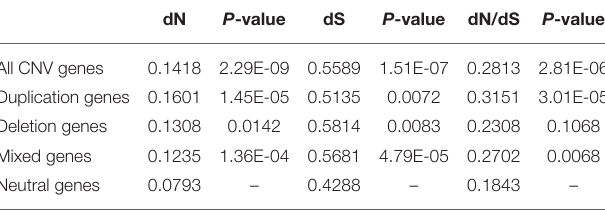
TABLE 4 | dN/dS analysis. TABLE 5 | Number of tissue-specific genes with copy number